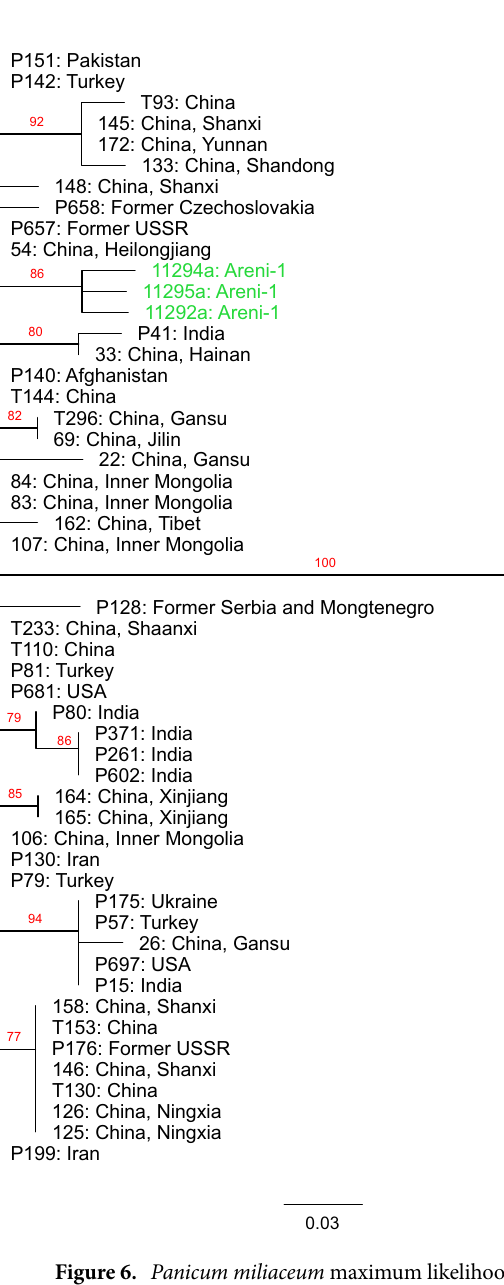
Figure 6. Panicum miliaceum maximum likelihood phylogeny. A RaxML maximum likelihood phylogeny generated using the chloroplasts genomes from the three Areni-1 grains and 50 modern accessions of P. miliaceum with rooting on the branch containing the two wild accession (31,167). The scale bar at the bottom of the phylogenies represents the substitutions per site. Accessions highlighted in green are the Areni-1 millet and the accession in blue are the wild P. miliaceum . Additional Bayesian and neighbour joining phylogenies of this data are given in Fig